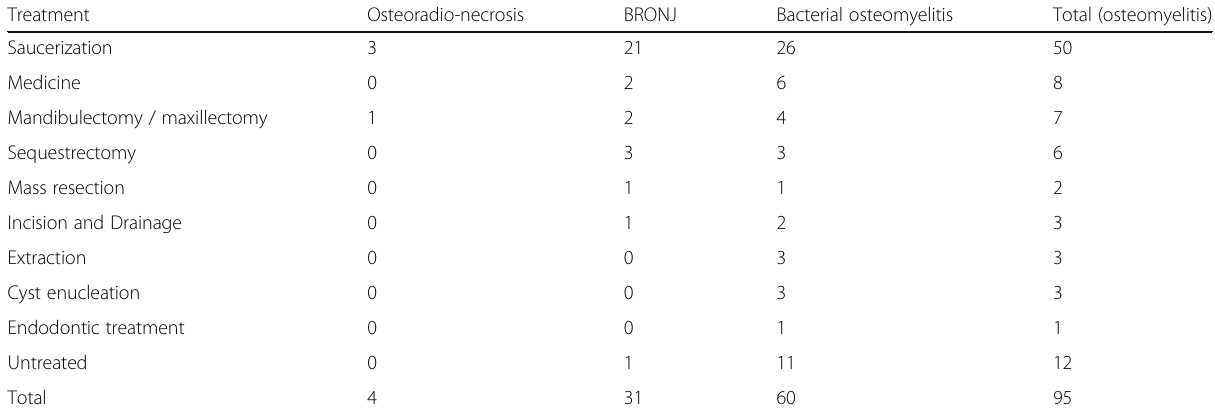
Table 2 Treatment of osteomyelitis patient